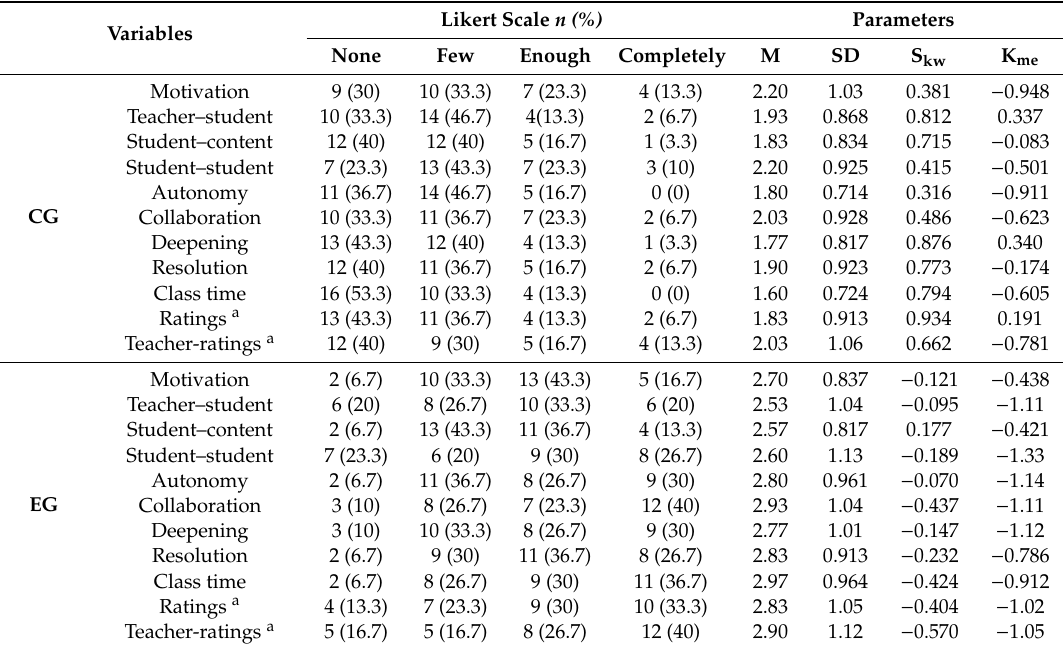
Table 4. Results obtained for the variables of study in the CG and the EG of secondary education (n =